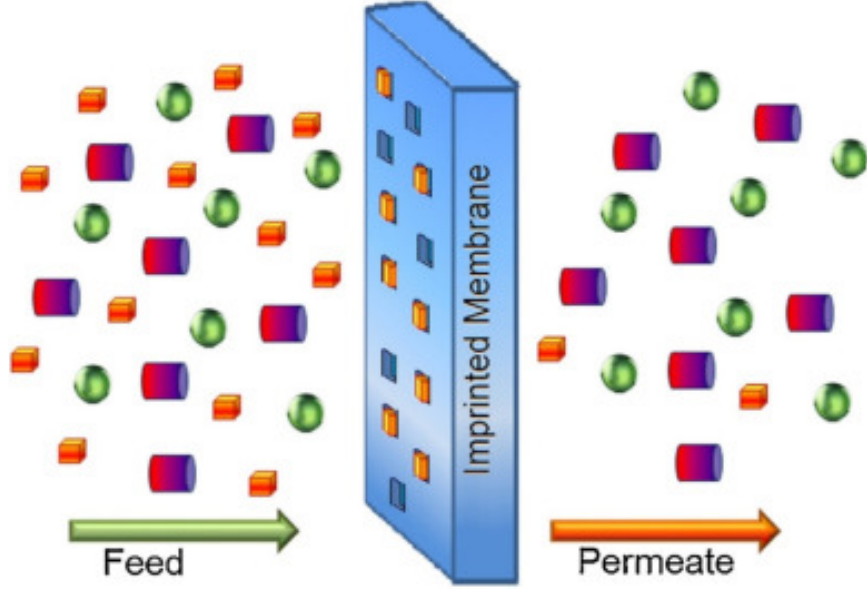
Figure 9. Removal of multiple contaminants selectively via an adsorptive membrane. Adapted from Salehi et al. [106].